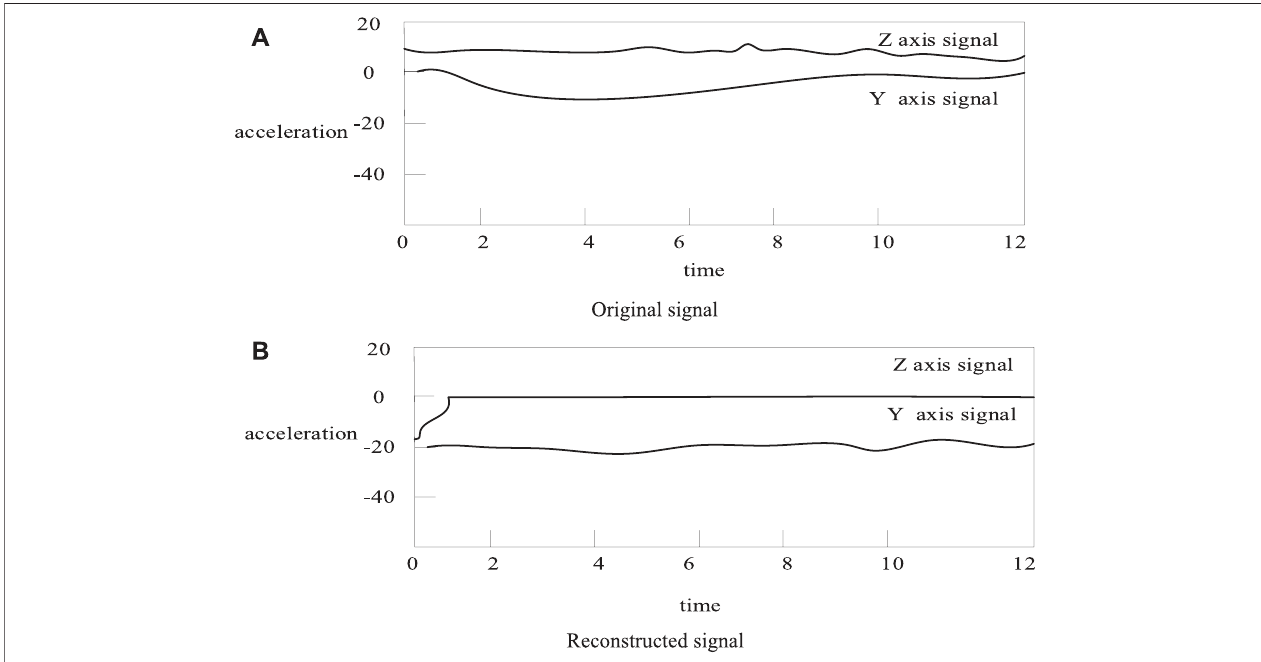
FIGURE 4 | Signal comparison before and after extended Kalman fi lter. (A) Original signal (B) Reconstructed signal.